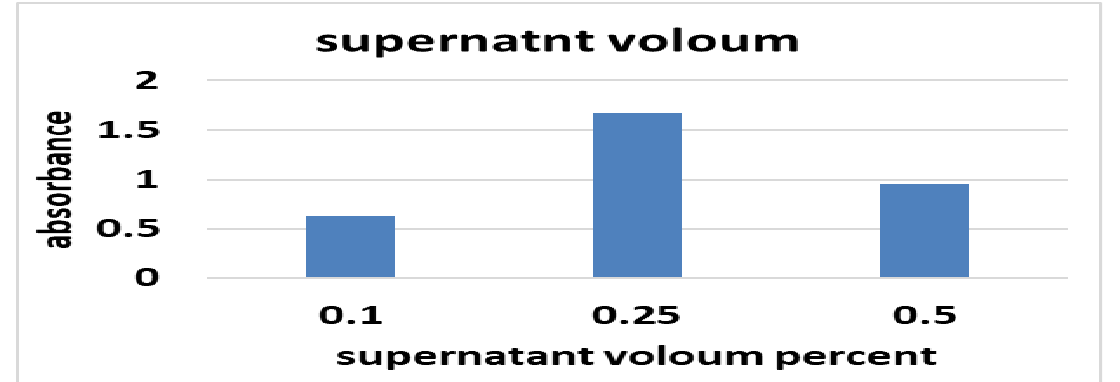
Figure 7. UV absorbance chart of final mixture after incubation with different supernatant volume 10, 25, 50 % of total